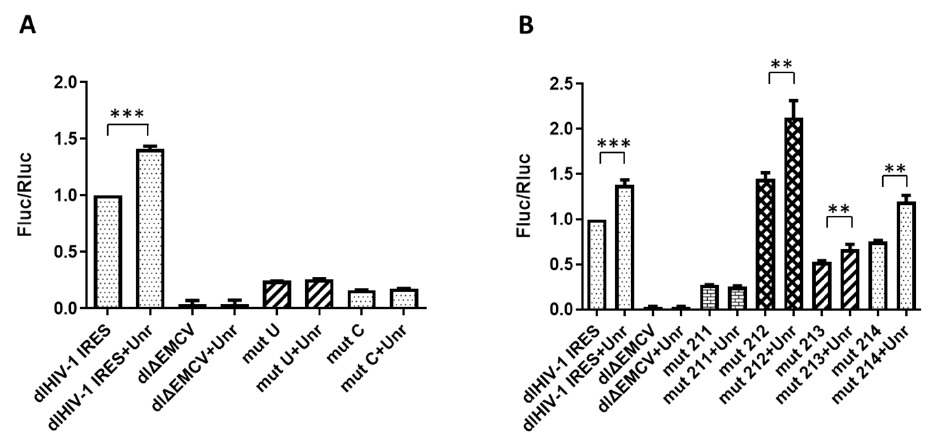
Figure 3. Determination of the activities of mutated HIV-1 IRES with/without Unr overexpression. ( A ) MutU and mutC IRES activities with/without Unr overexpression. ( B ) IRES activities of mut211, mut212, mut213 and mut214 with/without Unr overexpression. The IRES activity is expressed by the ratio of Fluc/Rluc luciferase activities in the dual luciferase assay. Measurements were performed in HeLa cells 24 h post transfection. The ratios are normalized to the ratio of the WT HIV-1 IRES without Unr overexpression. The construct dl ∆ EMCV corresponds to an inactive IRES control. Histograms represent the mean ± SEM of at least 3 independent experiments done in triplicate. ** p < 0.01; *** p < 0.001.